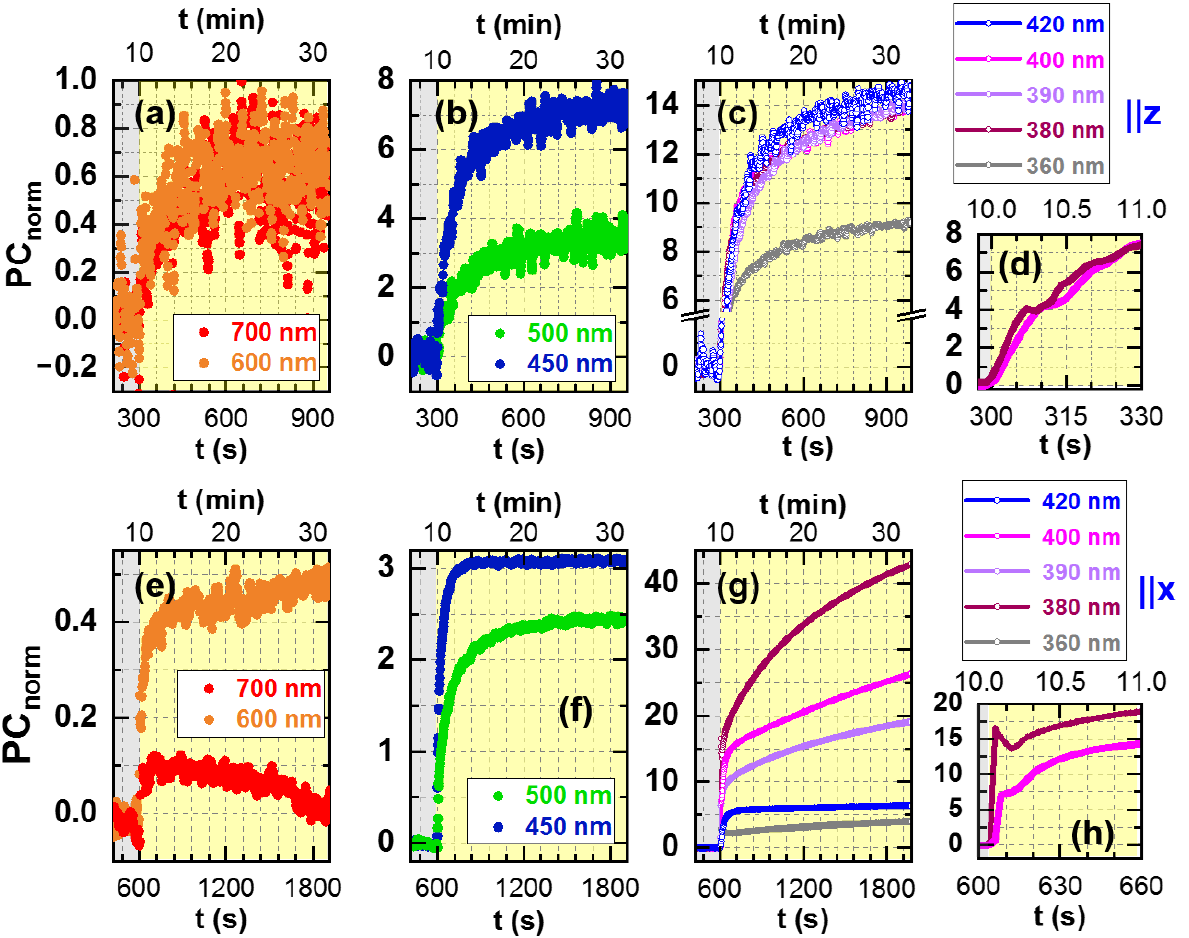
Figure 4. Temporal behavior of the normalized PC–light-on transients of the ( a – d ) z-cut and ( e – h ) x-cut SBN61 samples for selected wavelengths: greyish background indicating darkness and yellowish background indicating illumination. Subfigures ( d , h ), which are close-up fews of the first 60 s upon illumination for the cases of 380 nm and 400 nm, illustrate that especially for the x-cut case obviously multiple charge carrier transitions add up to a complex transient